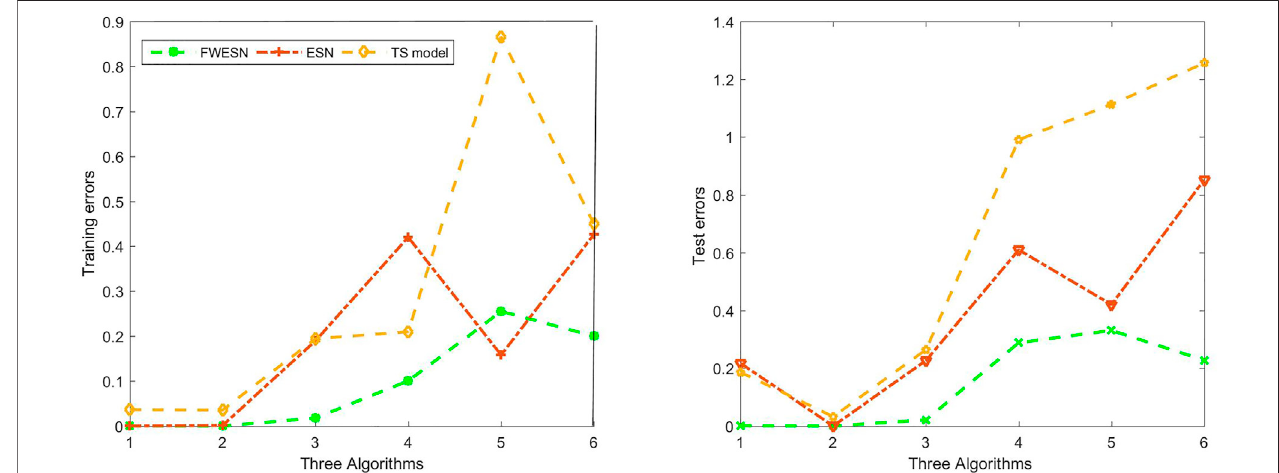
FIGURE 5 | Training and test errors for FWESN, ESN, and TS